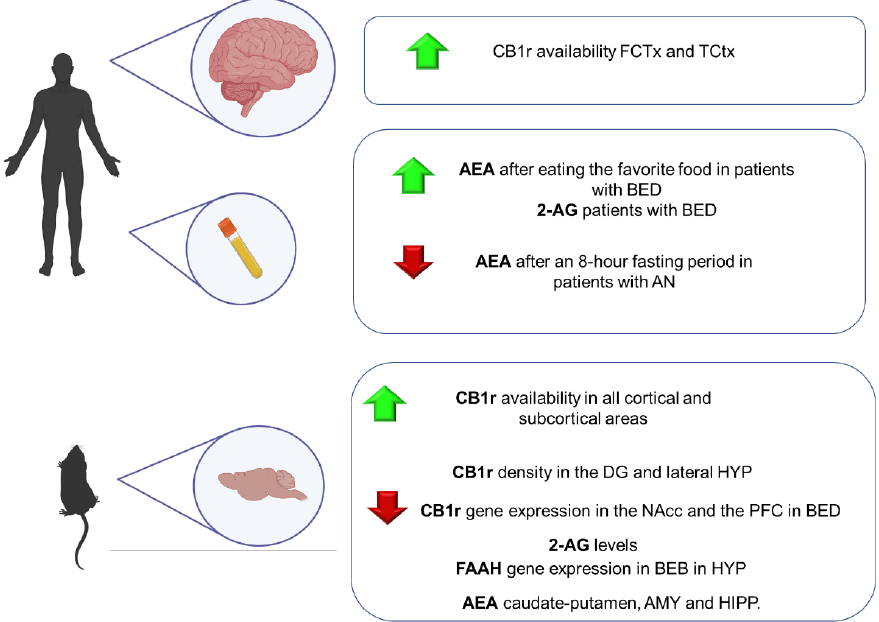
Figure 7. Main findings regarding the alterations of the ECS components in animal models and patients with eating disorders. 2-AG: 2-arachidonoylglycerol; AEA: anandamide; CB1r: cannabinoid receptor 1; CNR1 : gene encoding CB1r; HIPP: hippocampus; HYP: hypothalamus; BED: binge eating disorders; AN: Anorexia nervosa; DG: dentate gyrus; Nacc: nucleus accumbens; PFC: prefrontal cortex; FCTx: frontal cortex, TCtx: temporal cortex; BEB: binge eating